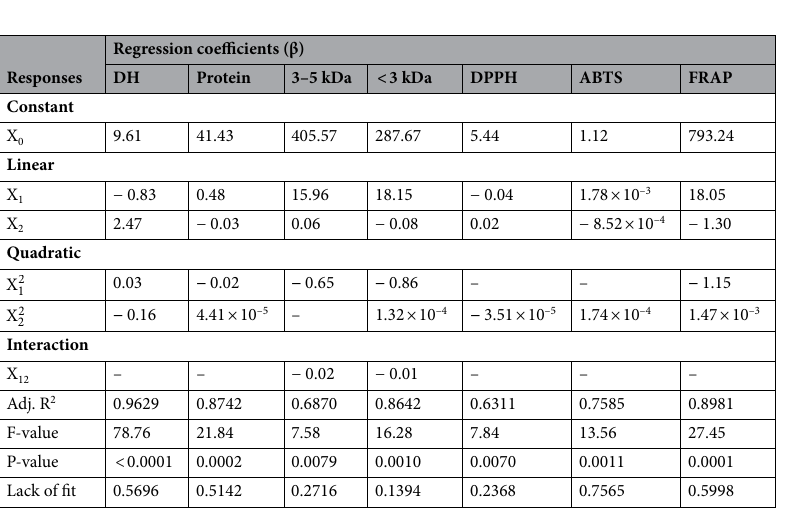
Table 3. Regression coefficient (β) and adjusted coefficient of determination (adj. R 2 ) of the predicted second- order model for the response